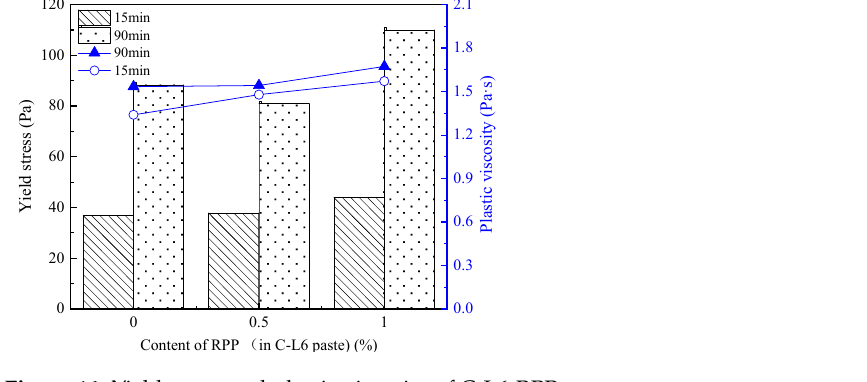
Figure 14. Yield stress and plastic viscosity of C-L6-RPP pastes.